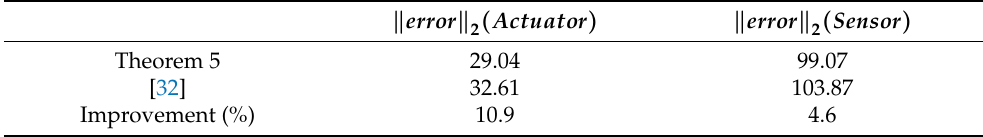
Table 1. The comparison of the norm specification of the simultaneous faults